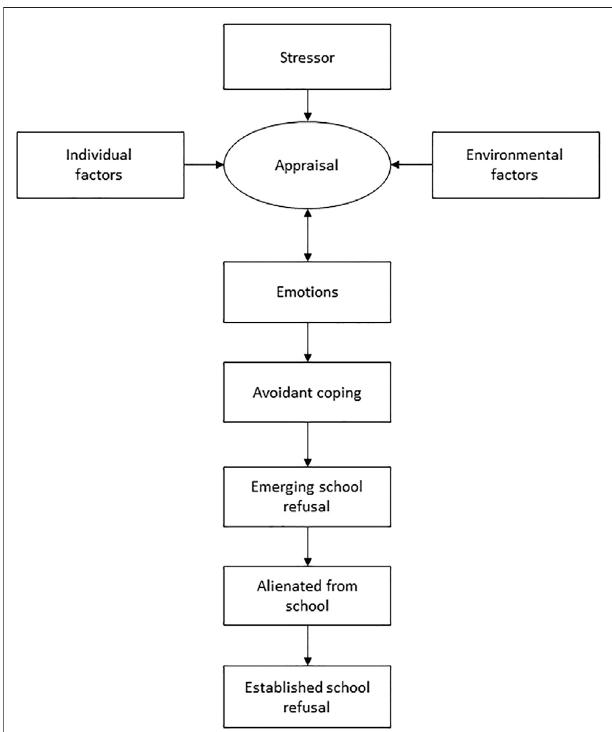
FIGURE 1 | Model to understand the development of